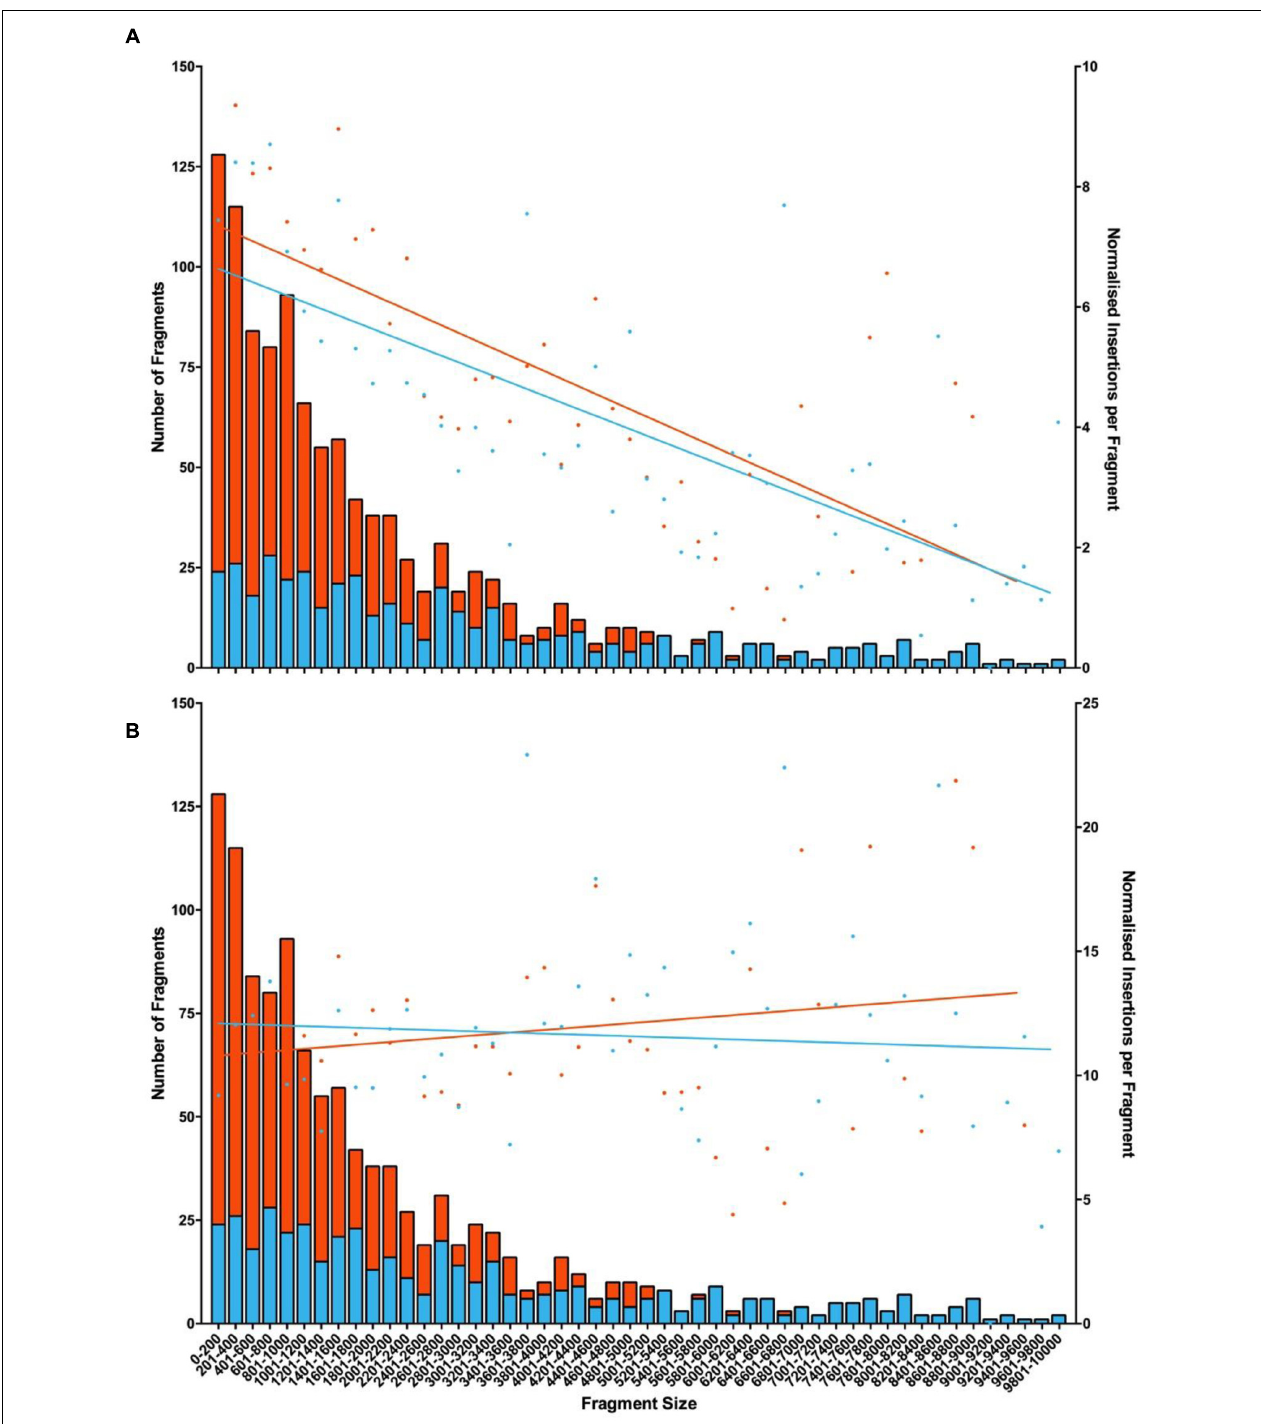
FIGURE 2 | Mapping insertions to restriction fragments following fragmentation with the corresponding endonuclease or by random acoustic shearing. Fragment length produced by either endonuclease was calculated. The number of insertions located to each fragment was determined and a linear regression of normalized insertion (NIM; Blanchard et al., 2015) was used to show any trends. Data represents NIM (dots right axis) mapped to fragments produced with endonuclease (left axis, orange bars = HindIII ; blue bars = EcoRI ). (A) NIM from corresponding endonuclease generated sample or (B) or acoustic sheared sample. R -values chart (A) HindIII (0.5476) and EcoR1 (0.5283); chart (B) HindIII (0.0255) and EcoR1 (0.0057).